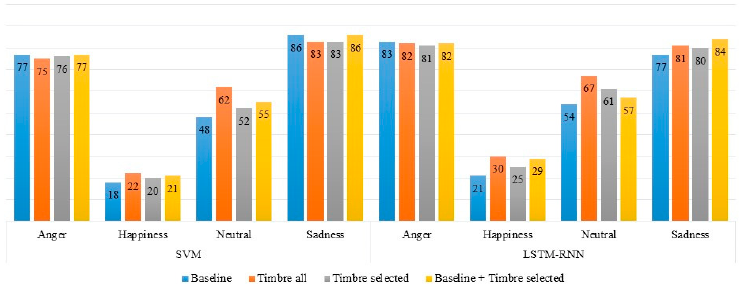
Figure 7. Recognition rates of discrete emotions on baseline, timbre all, timbre selected, and the combination of baseline and timbre selected acoustic features for IEMOCAP. Table 7. Comparison of the results in the literature with the proposed acoustic feature set for IEMOCAP. Literature